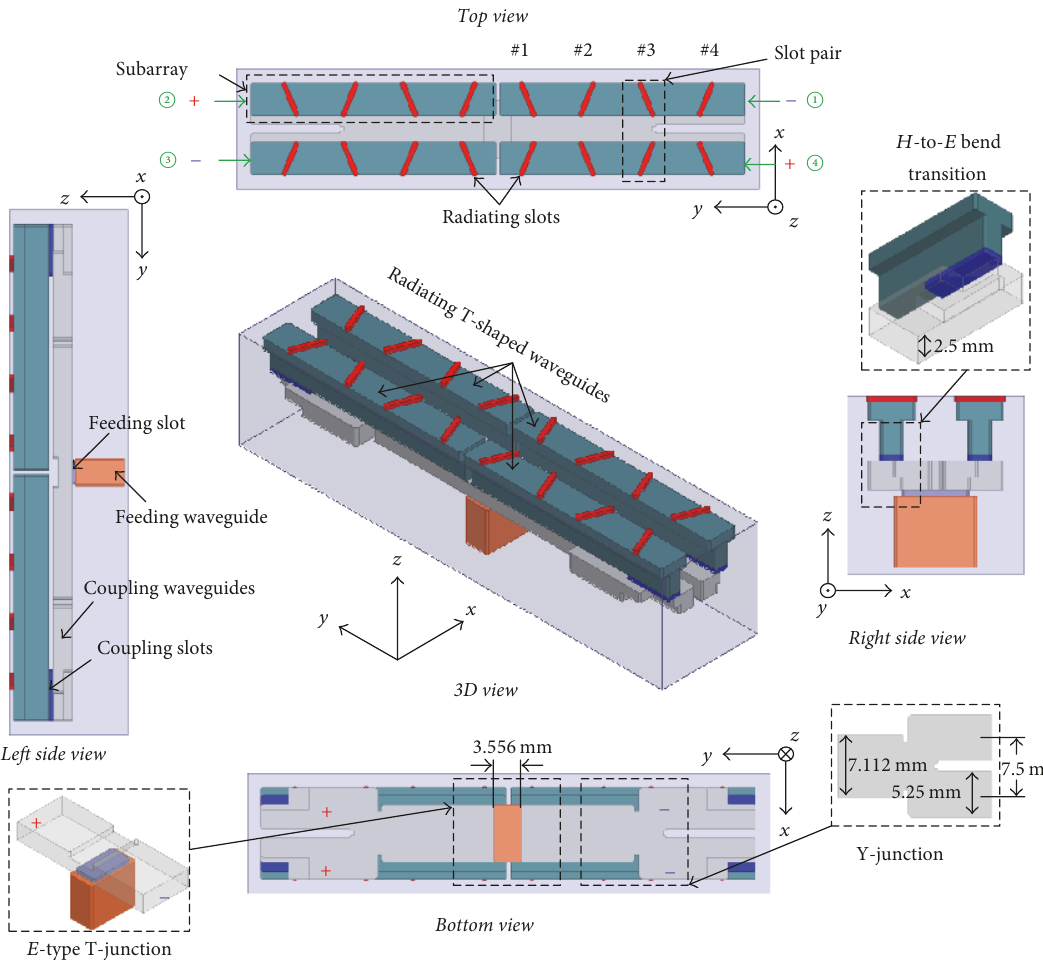
Figure 4: Structure of 2 × 8 antenna